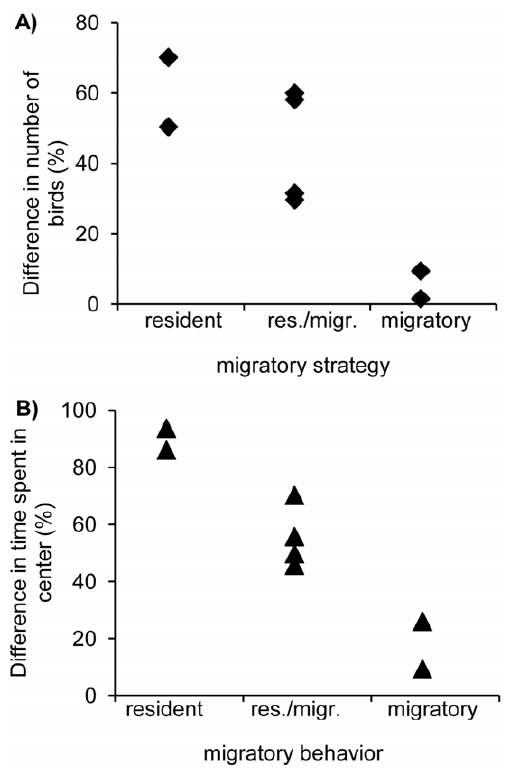
Figure 2. Relationship between neophobia reactions and migratory strategy. The difference in (A) number of individuals in center and (B) the difference in time spent in center between the first control and experimental trial (expressed as percent in relation to the control trial) are plotted against migratory strategy of the species. Res./ migr.: